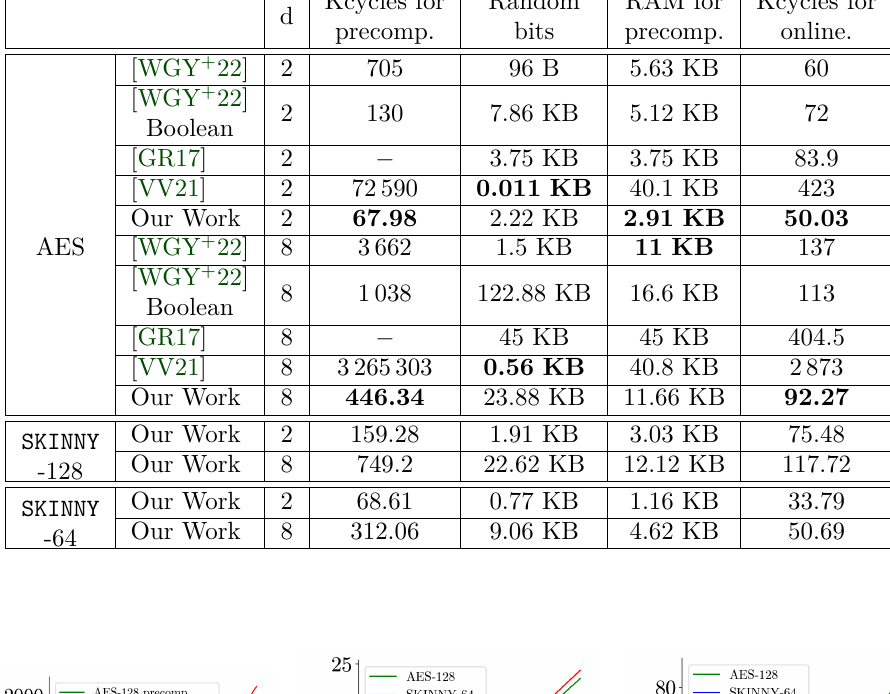
Table 4: Summary of masked implementations.